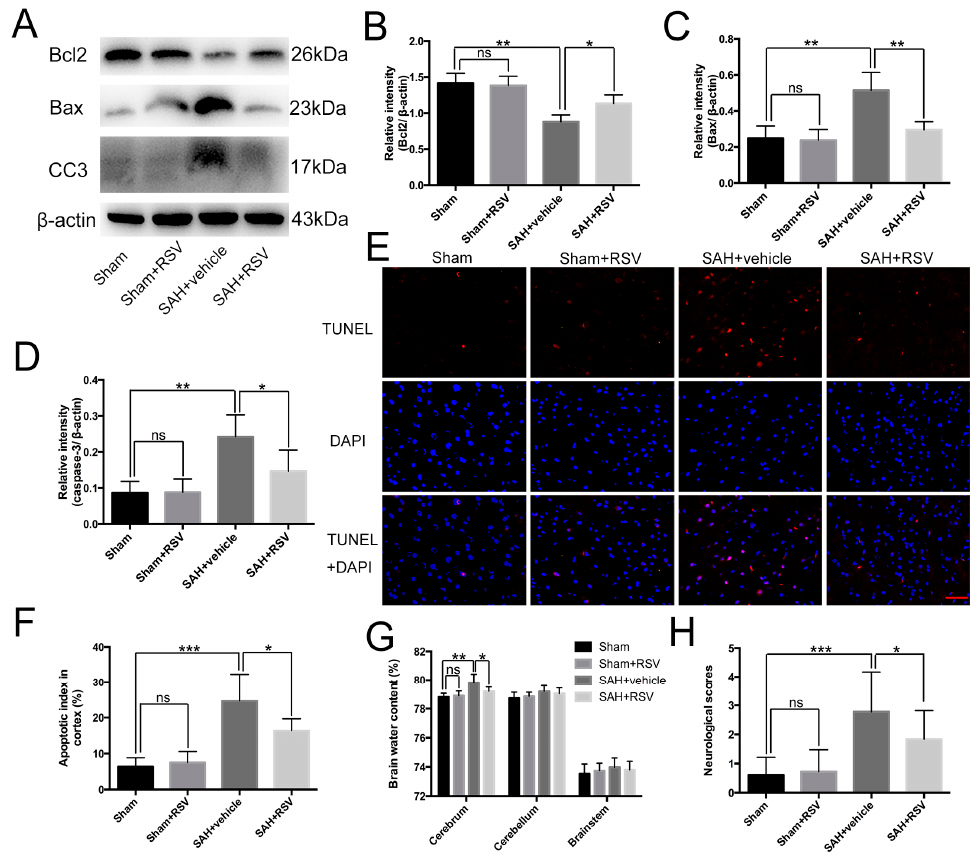
Figure 4. Effects of resveratrol (RSV) on neural apoptosis, brain edema, and neurological function at 24 h post subarachnoid hemorrhage (SAH). ( A – D ) RSV significantly reduced the elevated levels of cleaved caspase-3 and pro-apoptotic protein Bax, and enhanced the diminished level of Bcl2; ( E , F ) RSV administration markedly decreased the number of TUNEL-positive neural cells compared with the SAH + vehicle group; ( G , H ) RSV ameliorated brain edema and neurological behavior impairment at 24 h post SAH. Bars represent the mean ± SD. *** p < 0.001, ** p < 0.01, * p < 0.05, and ns means non-significant. Scale Bars = 50 µ m.